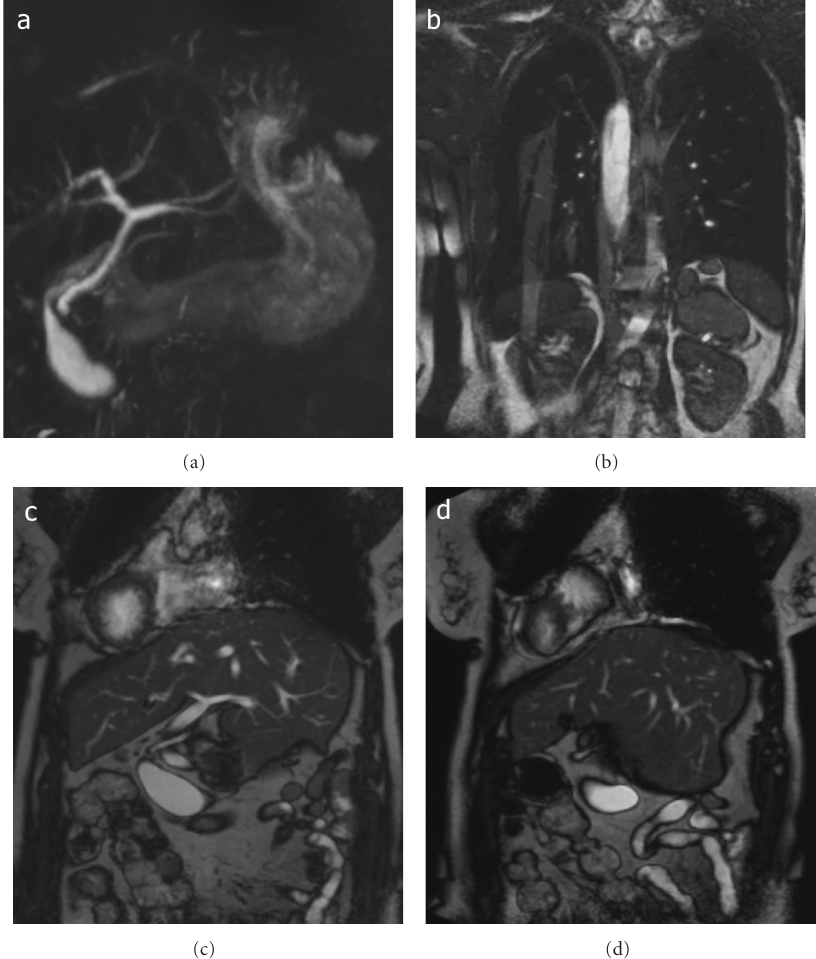
Figure 2: MRCP and BTFE-BH SENSE sequence on MRI. (a) MRCP imaging shows that the liver is left dominant in the midline, the common hepatic duct and common bile duct extend from the left superolateral to the inferomedial, and the pancreas is in normal location. (b) On coronal BTFE-BH SENSE sequence on MRI, the spleen is seen with three foci at the left below the liver congruent with polysplenism. (c) and (d) On coronal BTFE-BH SENSE sequence on MRI, the liver is left dominantly located at the both sides of the midline and the portal vein drains into the liver leading from the left. The intestines seem to be congruent with malrotation, and, predominantly, large intestines on the right-hand side and small intestines on the left-hand side according to the